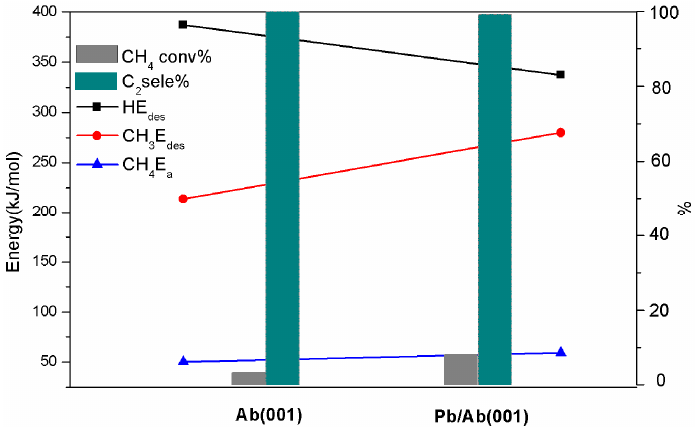
Figure 8. Effect of desorption energy of CH 3 and H, activation energy of CH 4 dissociation on CH 4 conversion and C 2 selectivity (1073 K) before and after doping on the (001) surface.